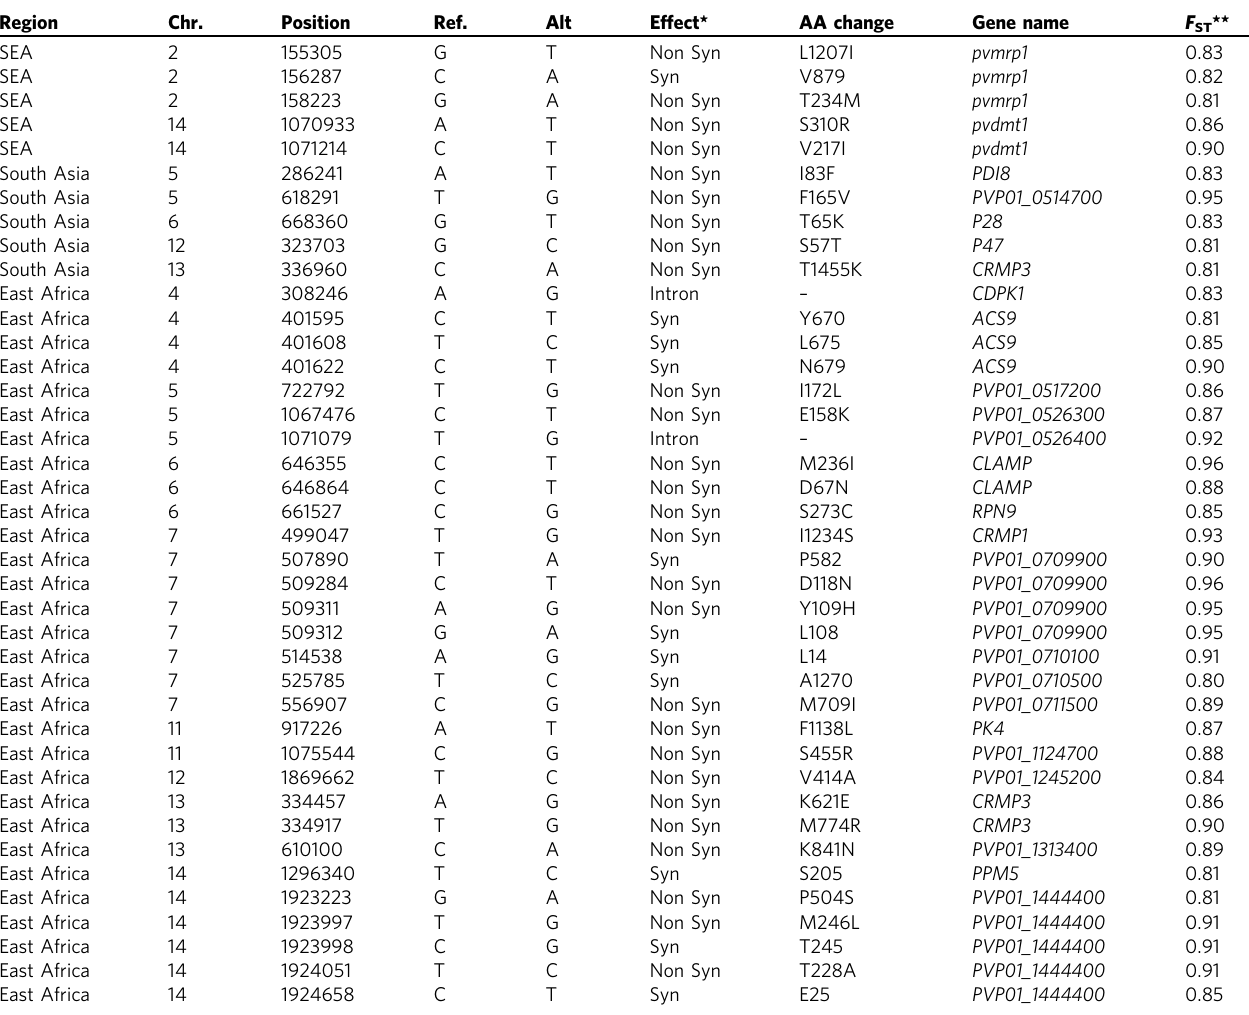
Table 1 SNPs with high F ST ( > 0.8) that differentiate P. vivax isolates from South East Asia (SEA), East Africa and South Asia regions. Region